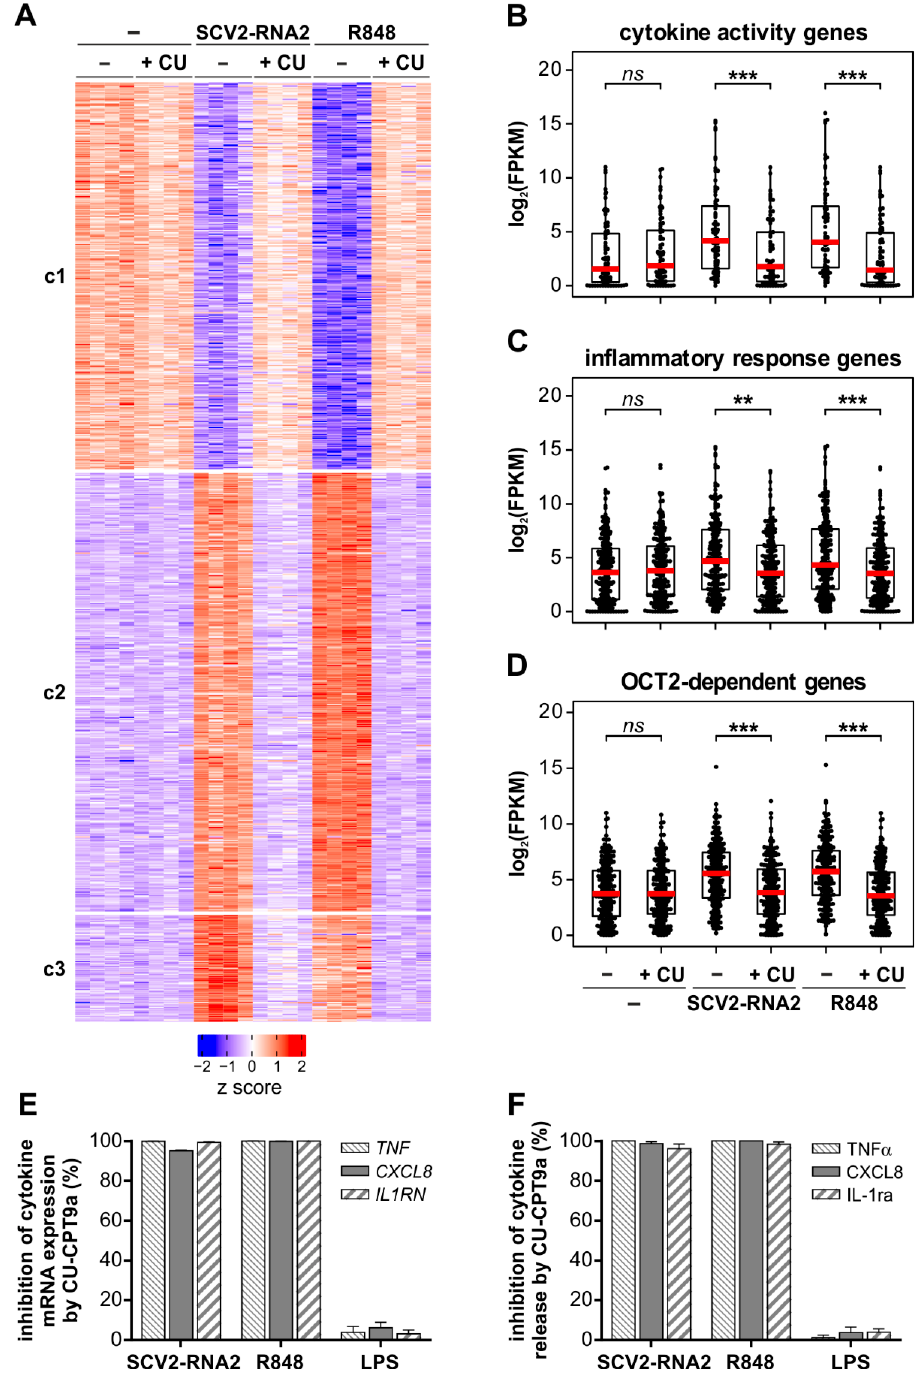
Figure 4. Effects of TLR8 inhibition in the transcriptome profiles of SCV2-RNA2 or R848 treated neutrophils, in cytokine mRNA expression and release. Neutrophils were stimulated with 10 μ g/mL SCV2-RNA2 and 5 μ M R848 in the presence or absence of the TLR8-specific inhibitor CU-CTP9a (10 μ M) and subjected to RNA-seq analysis. ( A ) Heatmap displaying the expression patterns of the gene cluster (c1–c3) resulting from the k-means clustering analysis of DEGs from Figure 3D. Relative expression levels for a single transcript were calculated by z score. ( B – D ) Box plots showing the distribution of mRNA expression levels [as log2(FPKM + 1)] for genes associated with the GO terms “cytokine activity” ( B ) and “inflammatory response” ( C ), and for OCT2-dependent genes ( D ). The box plot shows the median (red line) with the lower and upper quartiles representing a 25th to 75th percentile range. ( B – D ) Asterisks stand for significant inhibition caused by CU-CPT9a